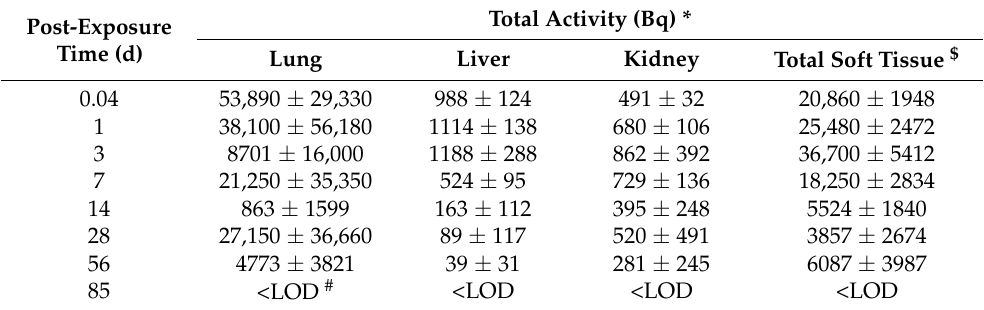
Total Activity (Bq) *